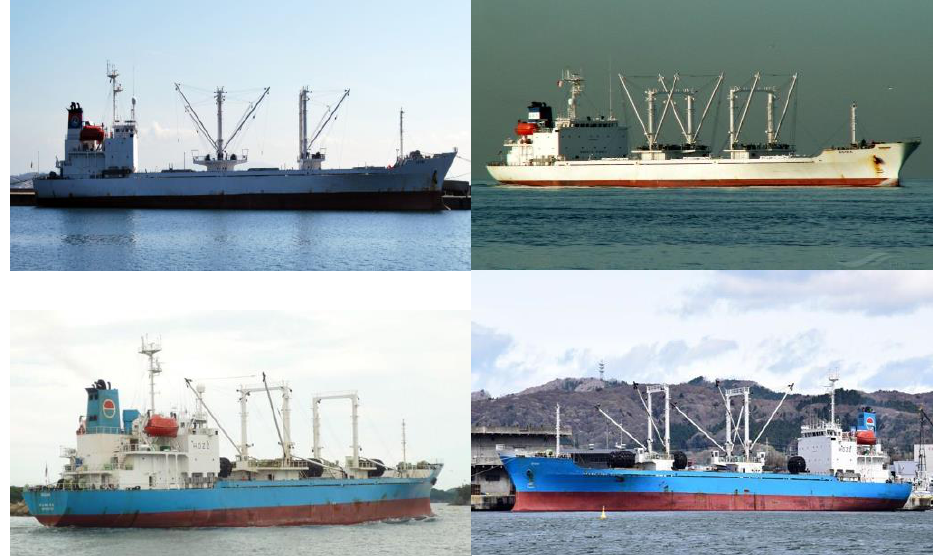
Figure 1. Search Results of SUAH_Reefer on Google.